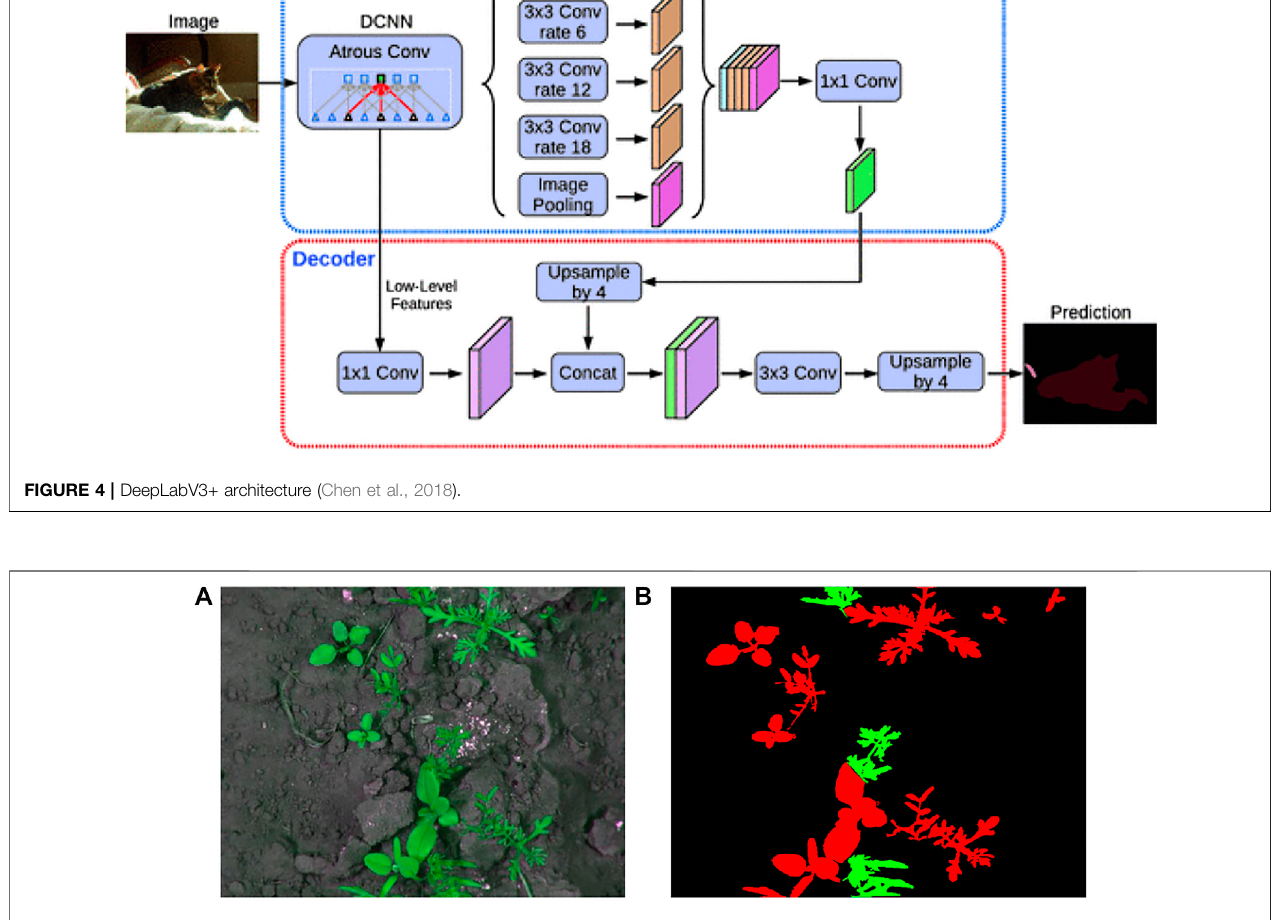
FIGURE 5 | Sample training images of CWFID dataset. (A) training image; (B) annotated image.